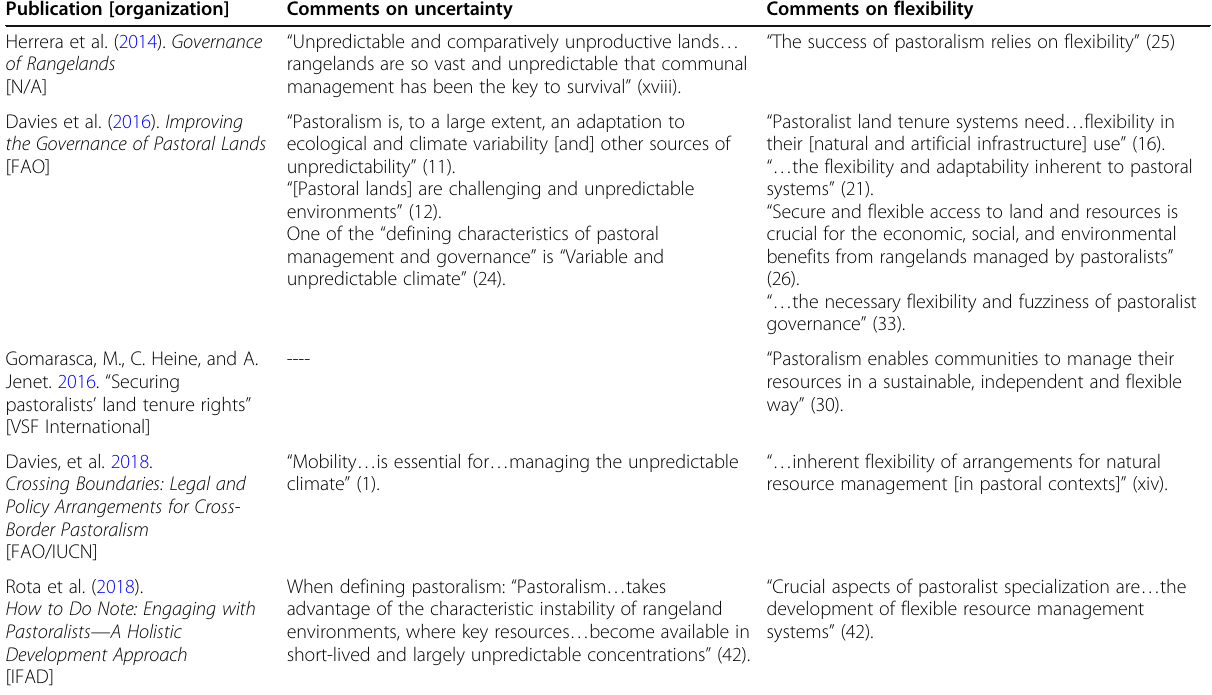
Table 1 Illustrative excerpts from practitioner publications regarding uncertainty and